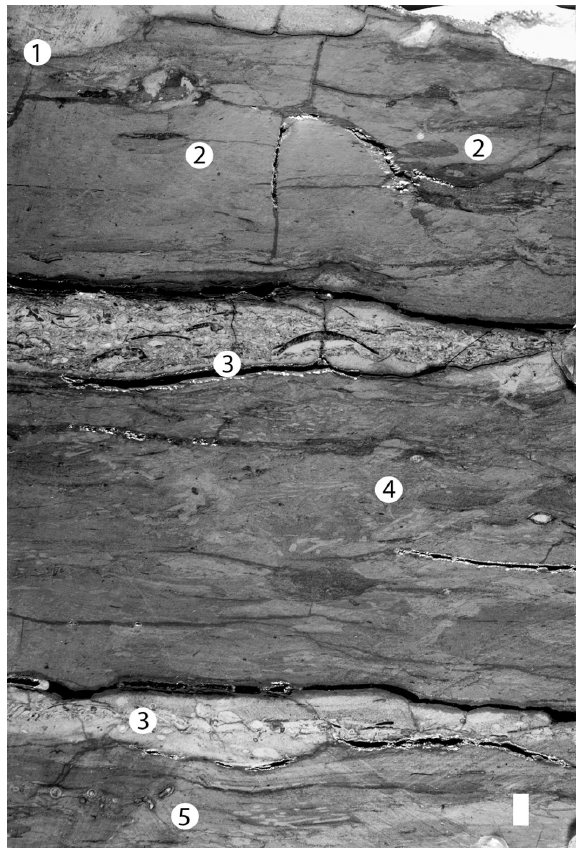
Fig. 2. Photograph of the sliced butter shale block. 1, Concretions; 2, Teichichnus ; 3, limestone lenses; 4, Chondrites zone; 5, in situ bryozoan colony. The scale bar is 1 cm.